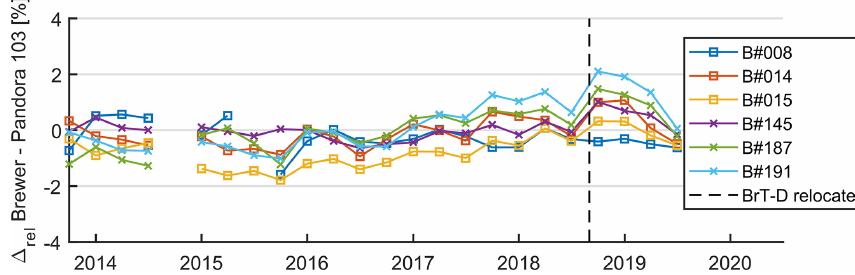
Figure 4. Three-month relative differences between Brewers and Pandora total column ozone. Three-month averages are calculated if there are at least 10 coincident measurements between Brewer and Pandora for that period. The black dash line represents the time when BrT-D was relocated to Egbert; i.e., Pandora and BrT-D were not co-located.